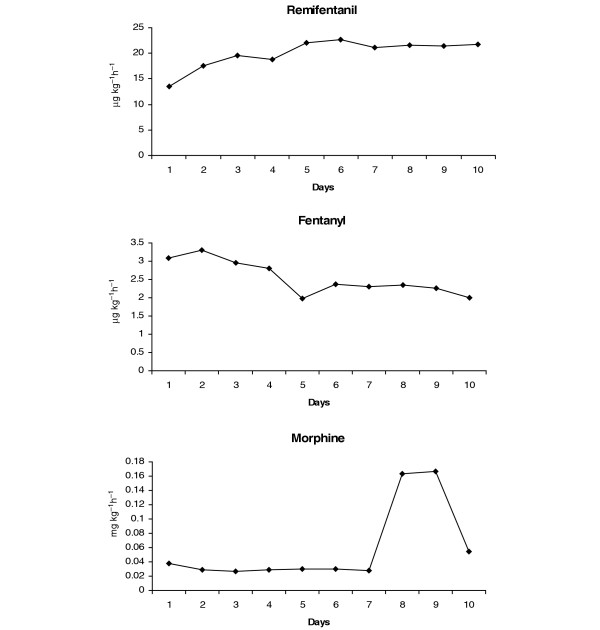
Mean weighted mean opioid infusion over time.